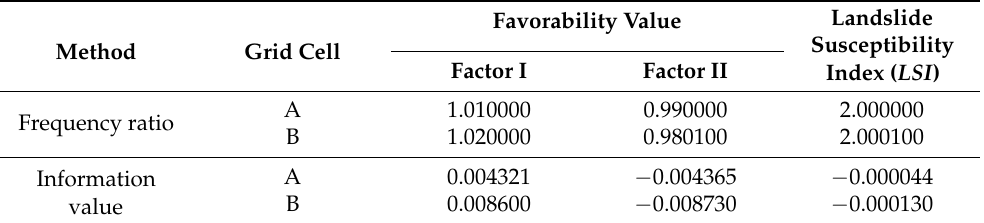
Table 3. Differentiation of the order of grid cells owing to the combination of favorability layers. Favorability Value Landslide Susceptibility Method Grid Cell Index ( LSI )Factor I Factor II A 1.010000 0.990000 2.000000 Frequency ratio B 1.020000 0.980100 2.000100 Information